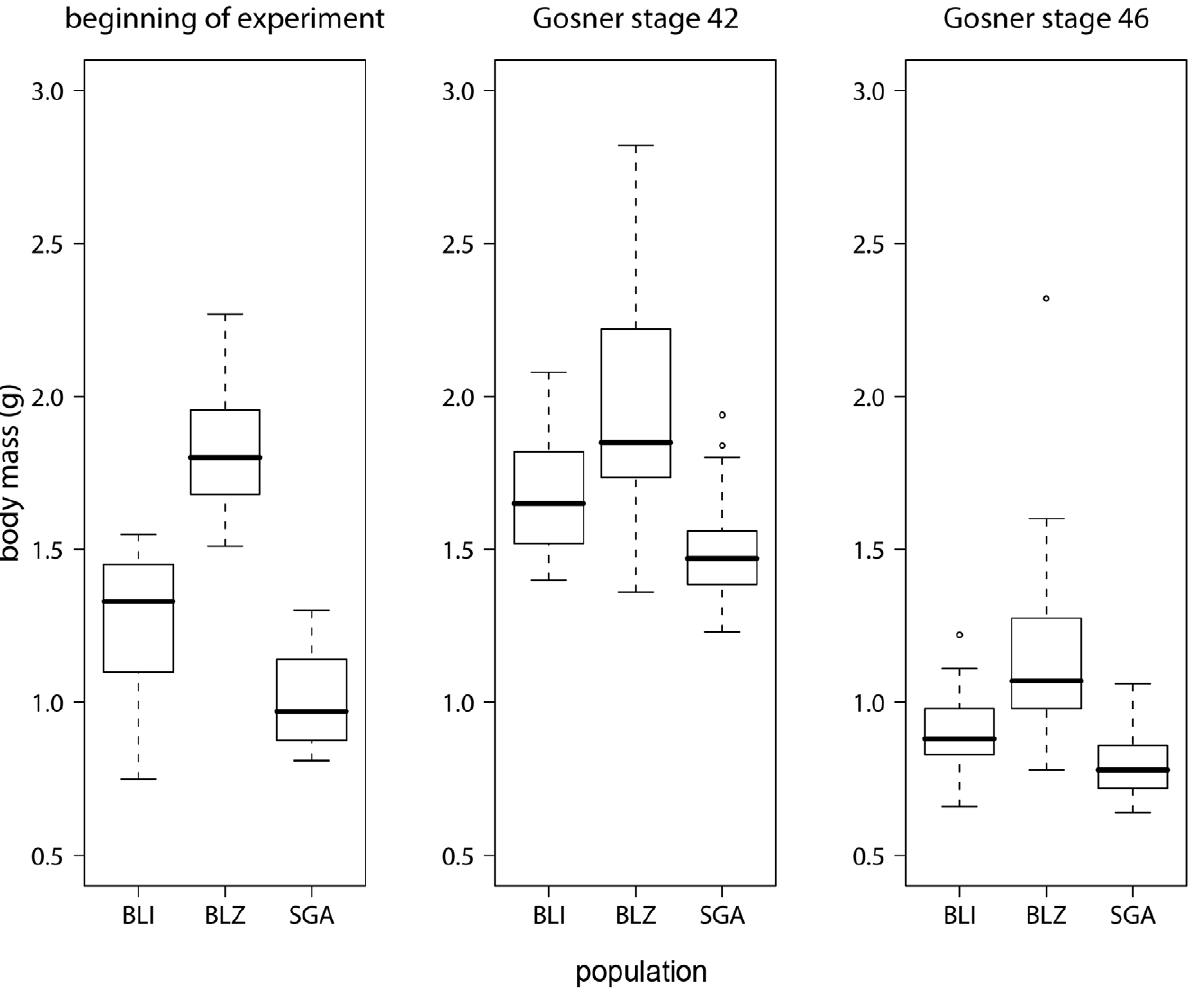
Figure 1. Differences in body mass between populations. Boxplots showing body mass of the different populations at the beginning of the experiment, at the start of metamorphosis (Gosner stage 42) and at the end of metamorphosis (Gosner stage 46). The black line represents the median, the box represents the interquartile range containing 50% of the values, and whiskers mark the 1.5 fold interquartile range. Outliers are marked with circles. Grey boxes=survivors, white boxes=non-survivors.